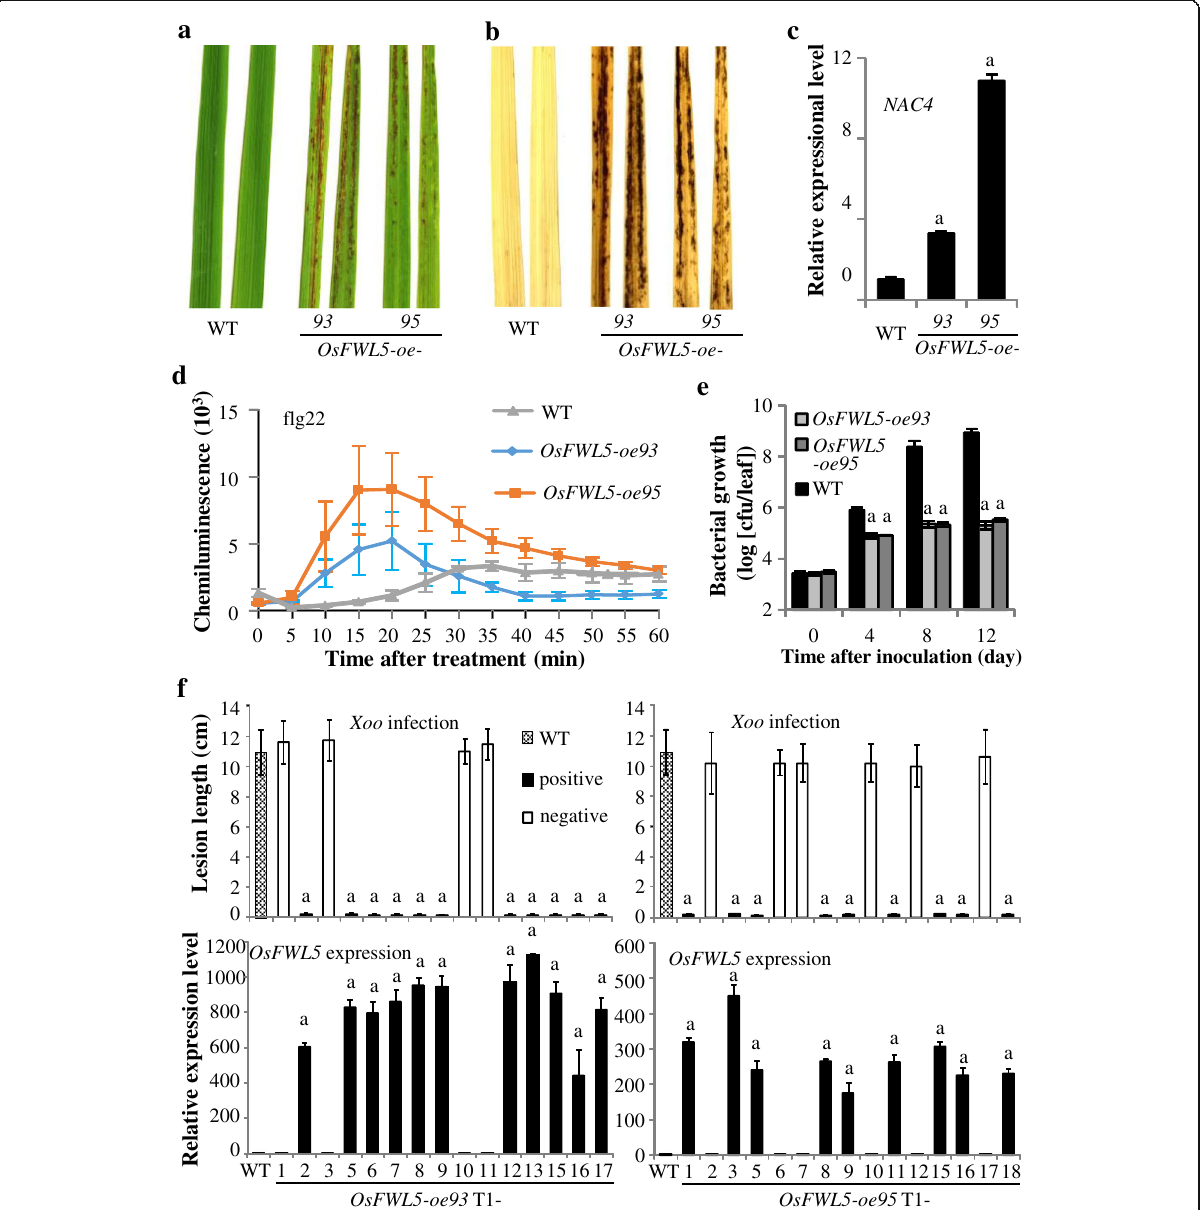
Fig. 1 Performance of OsFWL5-oe plants. The “ a ” above bars indicate significant differences compared to wild type (WT) at P < 0.01. Primers and methods are listed in Additional files 2 and 3. a Lesion mimic phenotype of 8-week-old OsFWL5-oe plants. b DAB staining of H 2 O 2 accumulation in 8-week-old OsFWL5-oe plants leaves. c NAC4 gene expression analysis in OsFWL5-oe plants leaves. Data are means ± SD ( n = 3). d Flg22- induced ROS burst in the OsFWL5-oe and WT plants. Rice leaf disks were treated with 1 μ M flg22 and water. ROS were detected with a luminol- chemiluminescence assay. Data are means ± SD ( n = 3). e Growth of Xoo strain PXO341 on the leaves of OsFWL5-oe plants. Data are means ± SD ( n = 3). cfu, colony-forming units. f Increased resistance of OsFWL5-oe plants to Xoo strain PXO341 was associated with increased OsFWL5 expression. Data are means ± SD (n = 3 for gene expression, and 3 to 5 for lesion